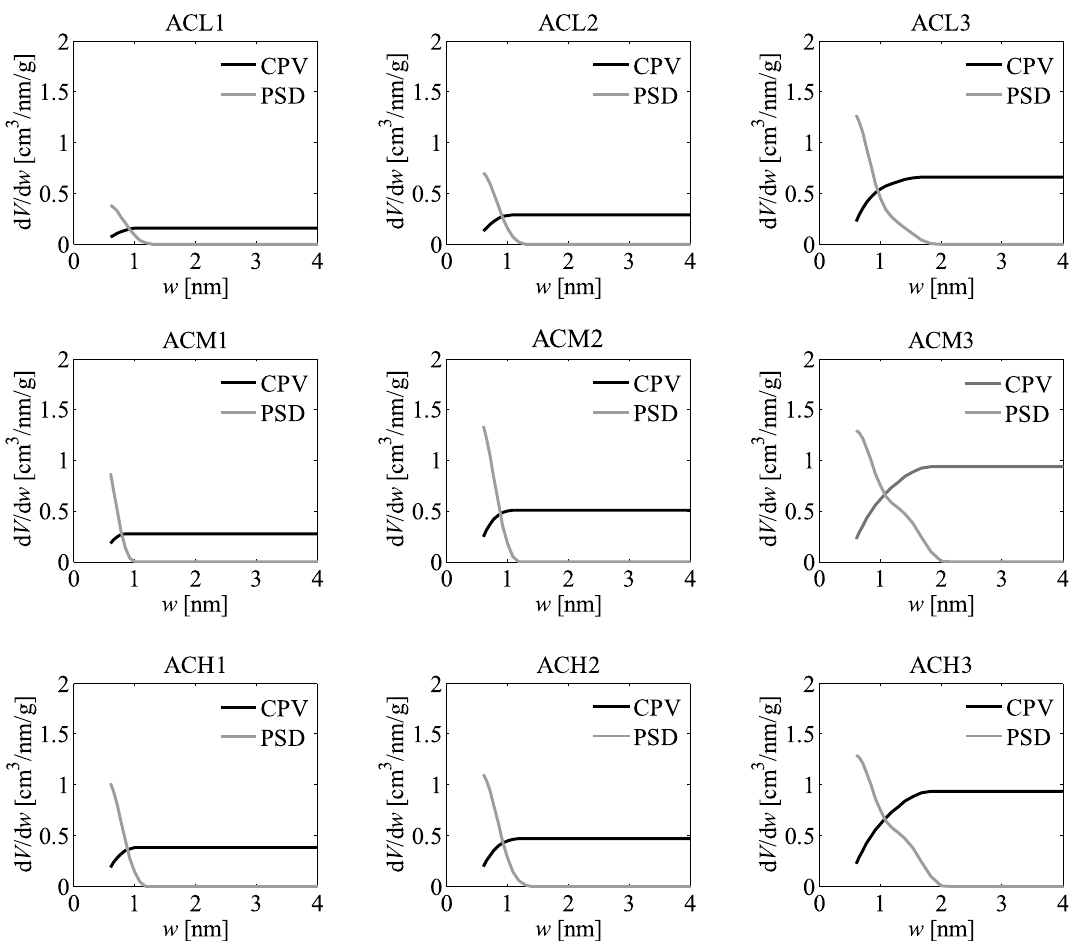
Figure 4. Pore size distributions (PSD) and cumulative pore volumes (CPV) obtained for the activated carbons developed by chemical activation of Pine cones with KOH, obtained with the different temperatures and impregnation ratios, by applying the QSDFT method to the corresponding nitrogen adsorption